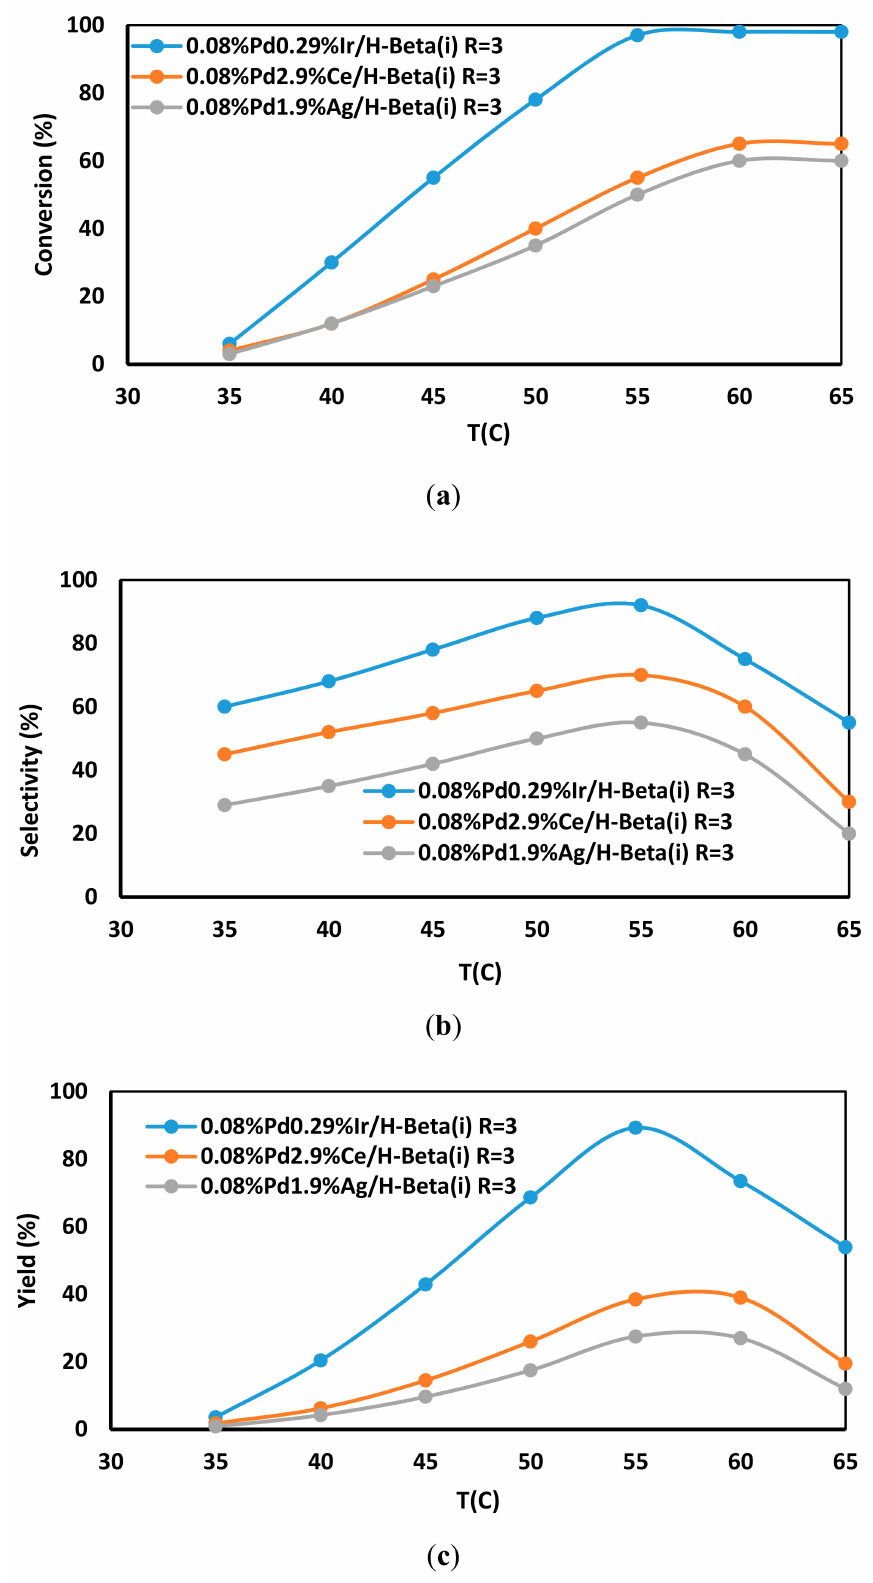
Figure 10. Acetylene conversion, ethylene selectivity, and yield over optimum catalysts under R = 3, p = 20 bar and GHSV = 4030 h − 1 . ( a ) Acetylene conversion; ( b ) ethylene selectivity; ( c )